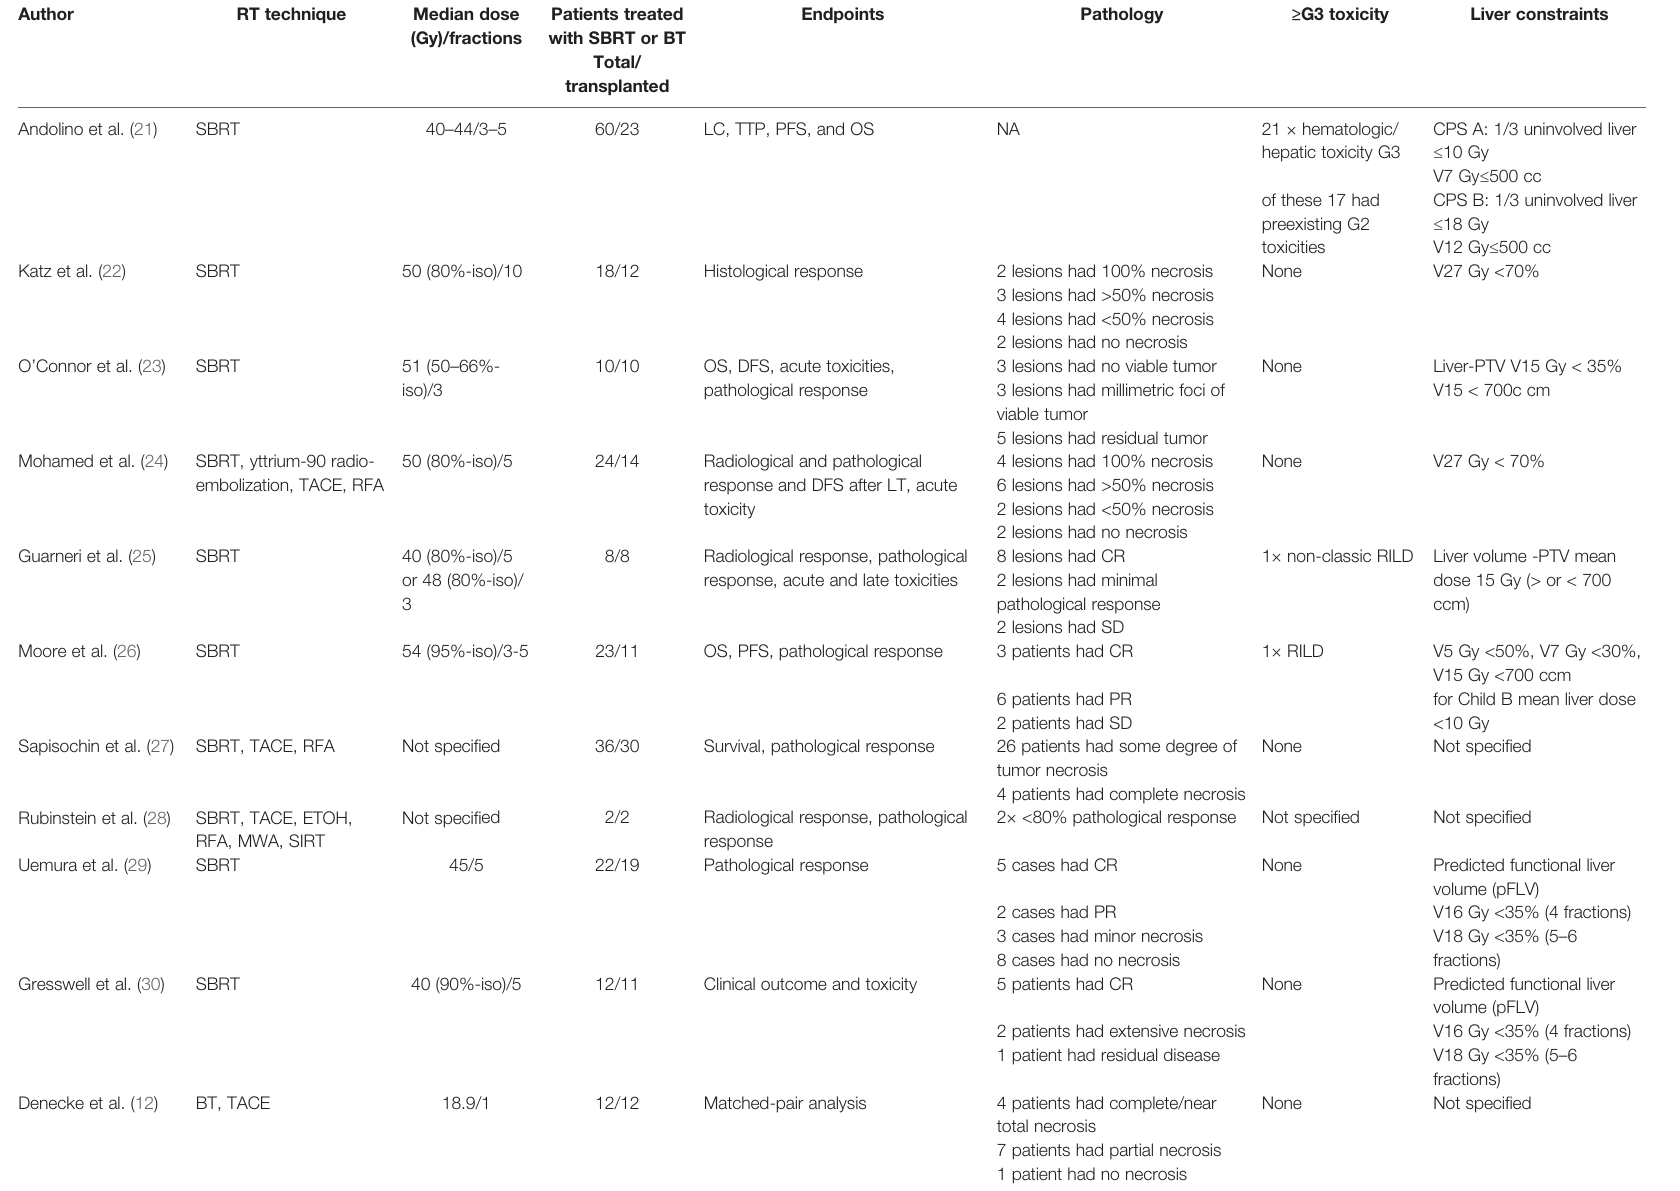
TABLE 3 | Literature on radiation-based therapy as bridging to